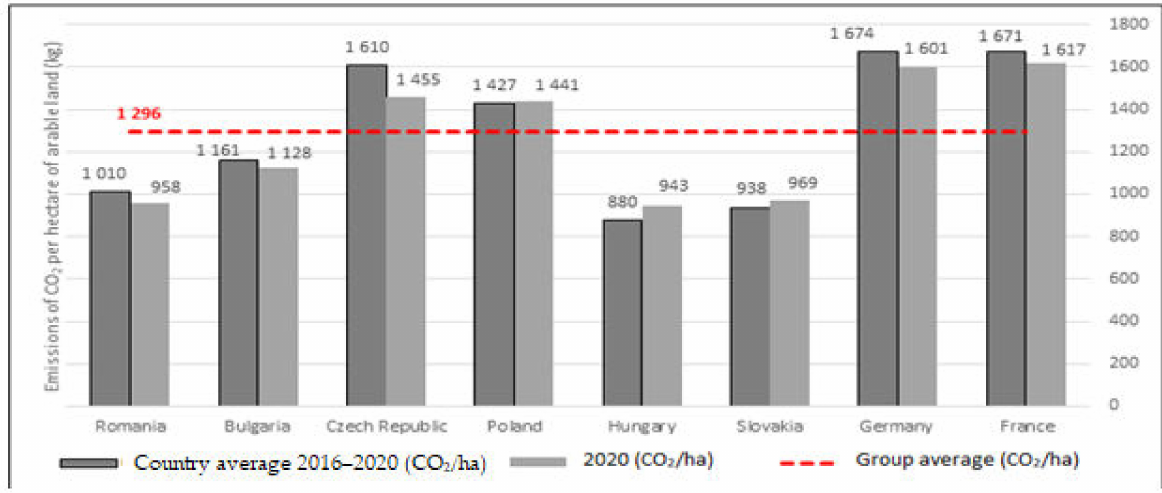
Figure 4. Emissions of CO 2 per hectare of arable land (kg). Source: own calculation based on